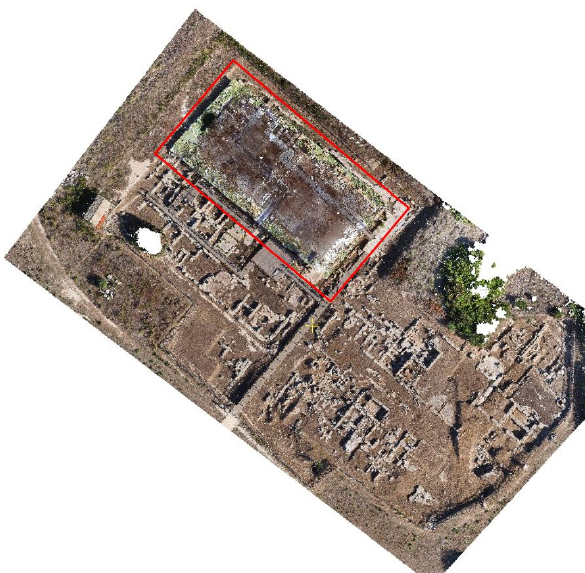
Figure 13. Integration of UAV model of the whole Insuale archaeological area and TLS model of the Roman